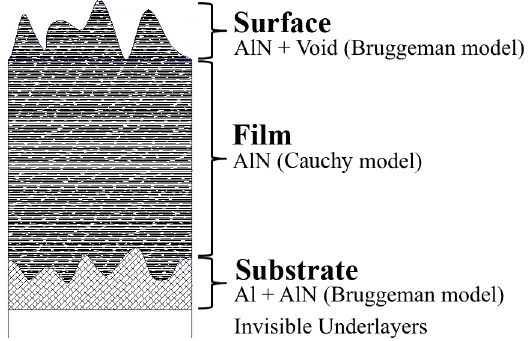
Figure 1. Principal scheme of an ellipsometry multilayer